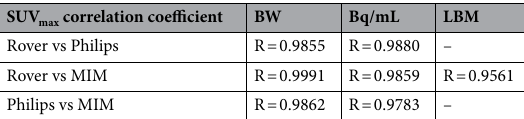
Table 1. Pearson correlation coefficient for SUV max values.